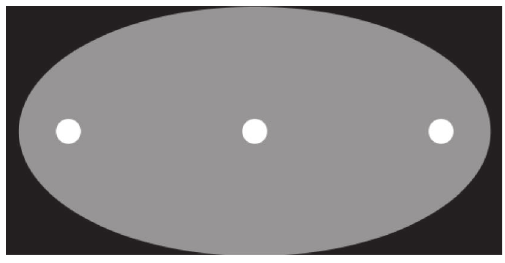
Figure 1: Illustration of the numerical ellipse phantom used for resolution-noise